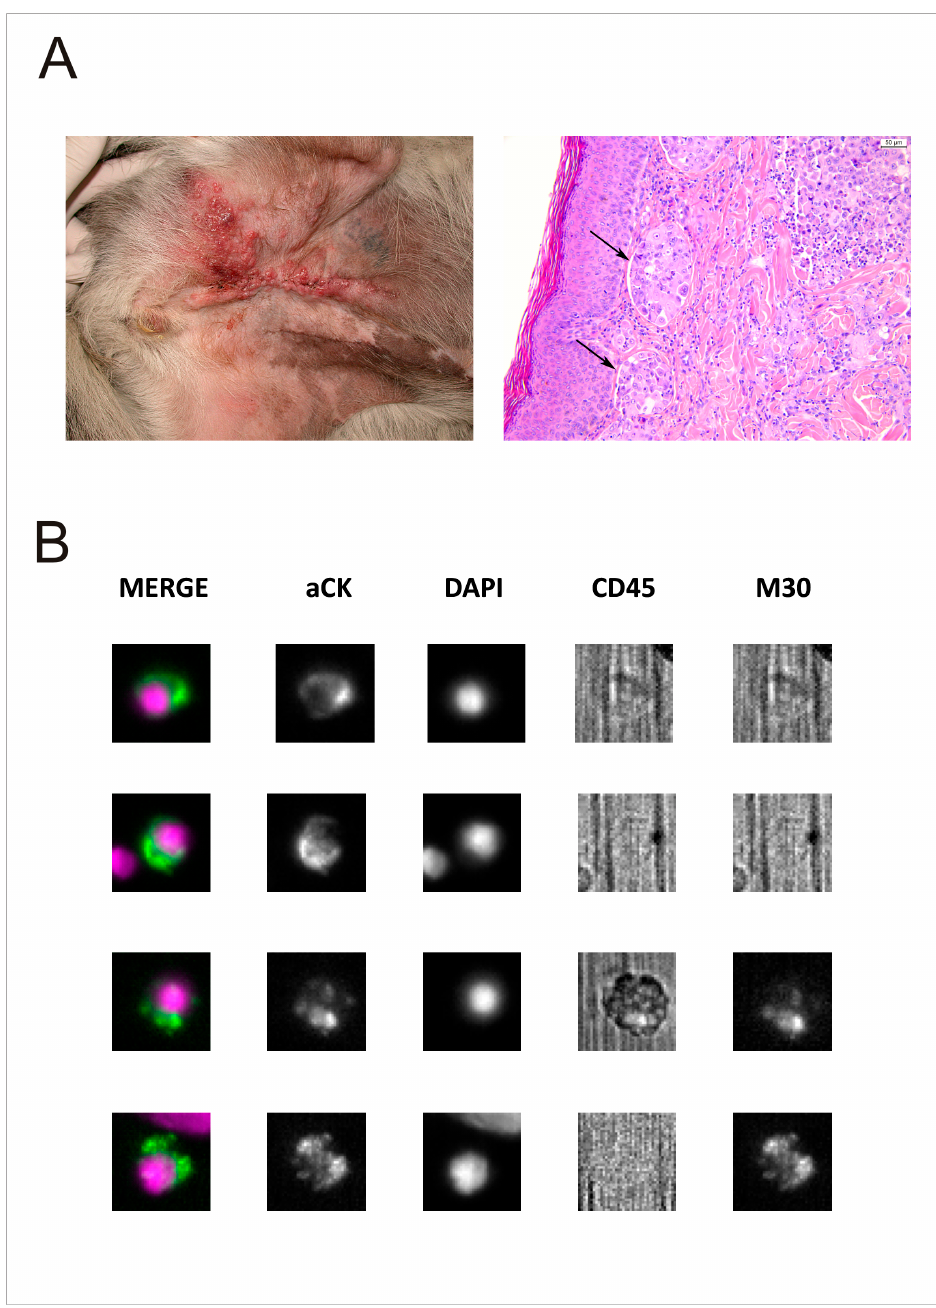
Figure 1. Clinical and histological characteristics and CTC/DTC enumeration of inflammatory carcinoma of dog. ( A ) A representative case of MMC (DOG-16), out of 10 is shown. On the left, mixed breed dog, 11 years old, spayed female, affected by inflammatory mammary carcinoma. On the right, in skin section sheets of anaplastic carcinoma, epithelial cells infiltrating the dermis and invading lymphatic vessels (arrows) are evident. Haematoxylin and eosin stain, 20× magnification. ( B ) Analysis of 4 out of 16 rare cells detected in baseline BM sample of DOG-16, using an Analyzer II device (Menarini). Horizontally, the photos show the same cell stained for the combination (MERGE) of CK (green) and DAPI (violet); CK PE only; DAPI only; CD45 APC only; and M30 FITC only. Based on M30 staining profile (sufficient signal relative to background) we classified the last 2 cells as M30-positive (apoptotic) DTCs. We did not find any CTCs in the PB collected at the same time of BM sample.